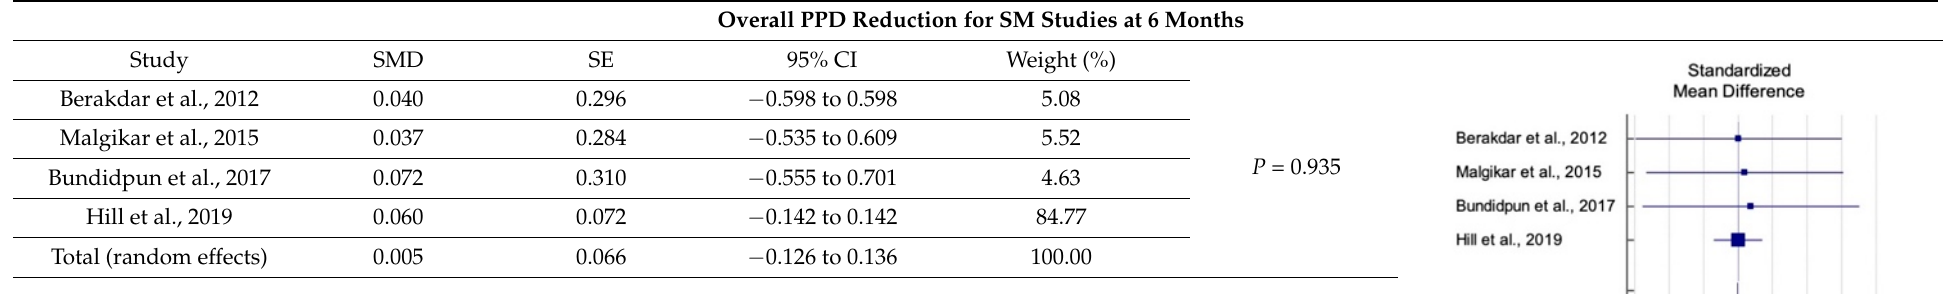
Table 4. Forest plots illustrating the overall PPD reduction and CAL gain at 6 months. Refer to Supplementary file 2 for a list of abbreviations.